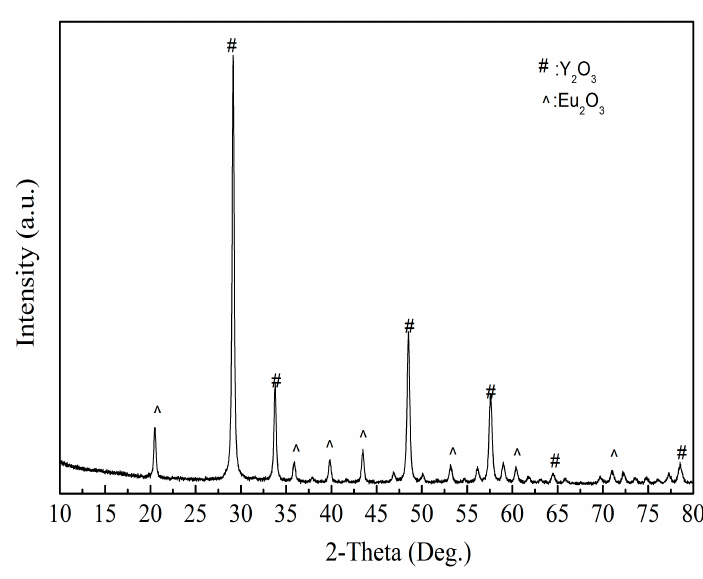
Minerals 2016 , 6 , 109